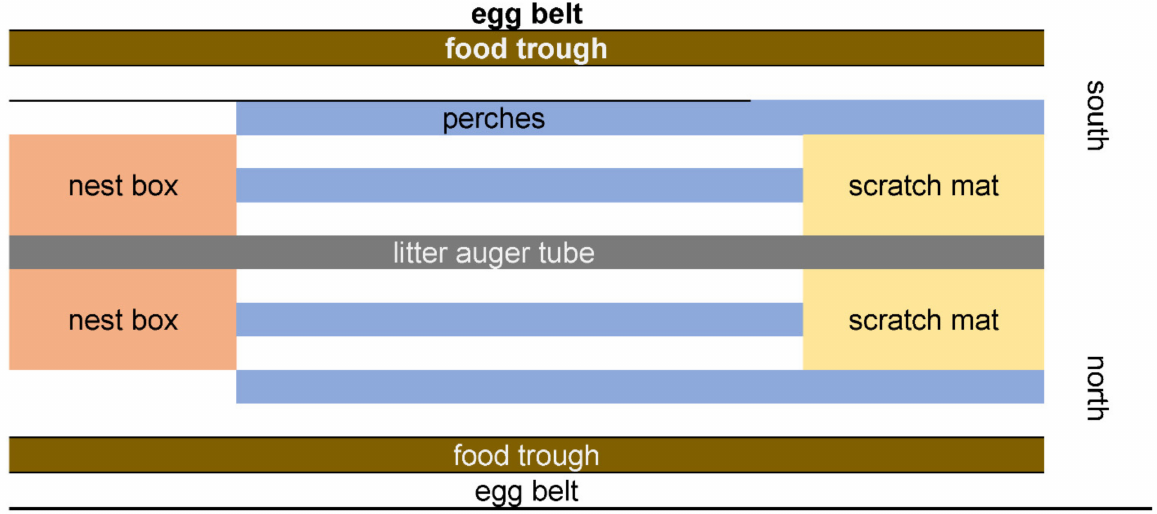
Figure 1. Overhead view of one enriched cage (not to scale), with furniture (nest boxes, perches, and scratch mats) locations noted. Cages spanned an entire bank width, and so cage sides were referred to as north or south.